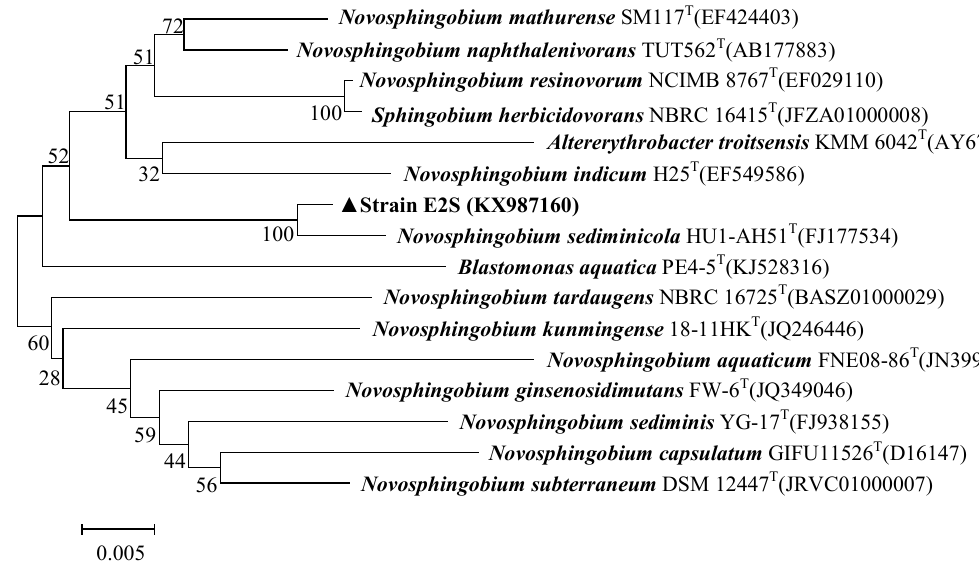
Figure 2. Phylogenetic tree of Novosphingobium sp. strain E2S and closely related species. The tree was constructed using the neighbor-joining method based on 16S rRNA gene sequences. The bar represents a genetic distance of 0.005.